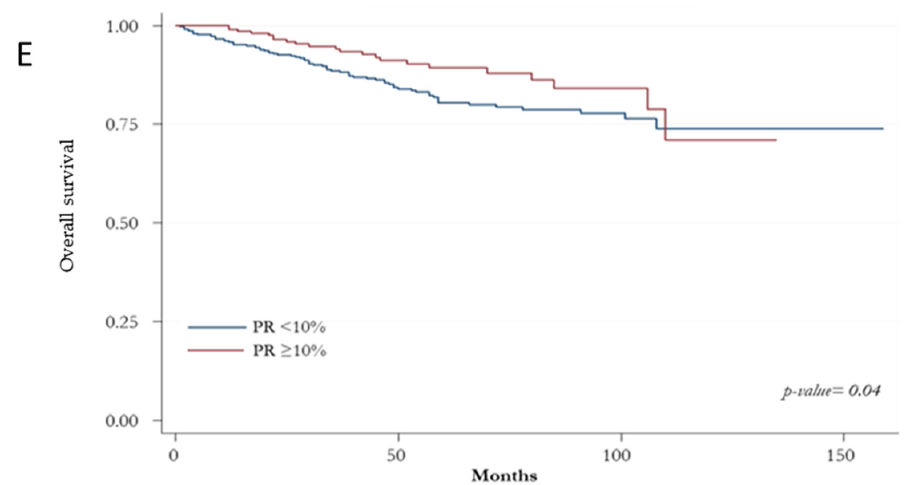
Figure 2. Kaplan-Meir curves for overall survival. ( A ) overall survival according to HER2-positive subtypes based on the state of the hormonal receptors (ER, PR and AR); ( B ) overall survival according to histologic grade; ( C ) overall survival according to prognostic stage; ( D ) overall survival according to lymph node ratio; ( E ) overall survival according to absence/presence of immunostaining for PR.